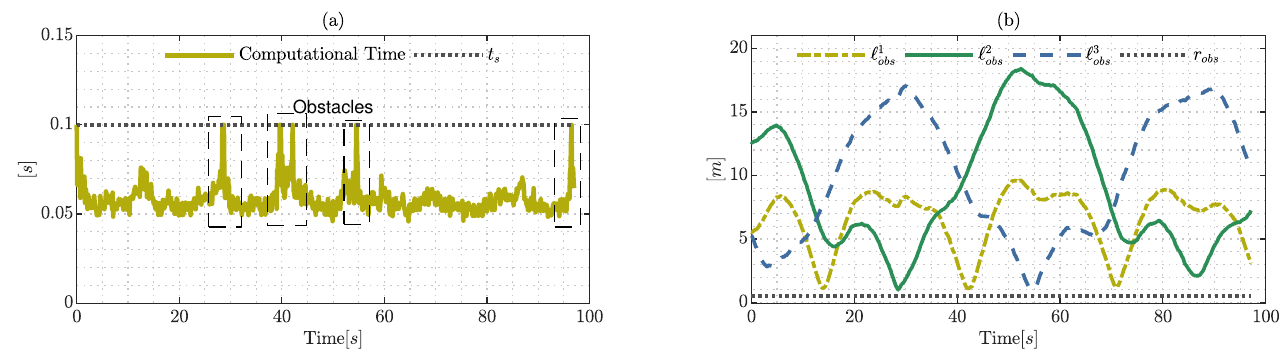
Figure 18. Computational time and distance to obstacles: ( a ) represents the time to solve the optimiza- tion problem; and ( b ) shows the distance to the obstacles, where (cid:96) 1 distances and r obs is the radius of security considering the dimensions of the hexarotor